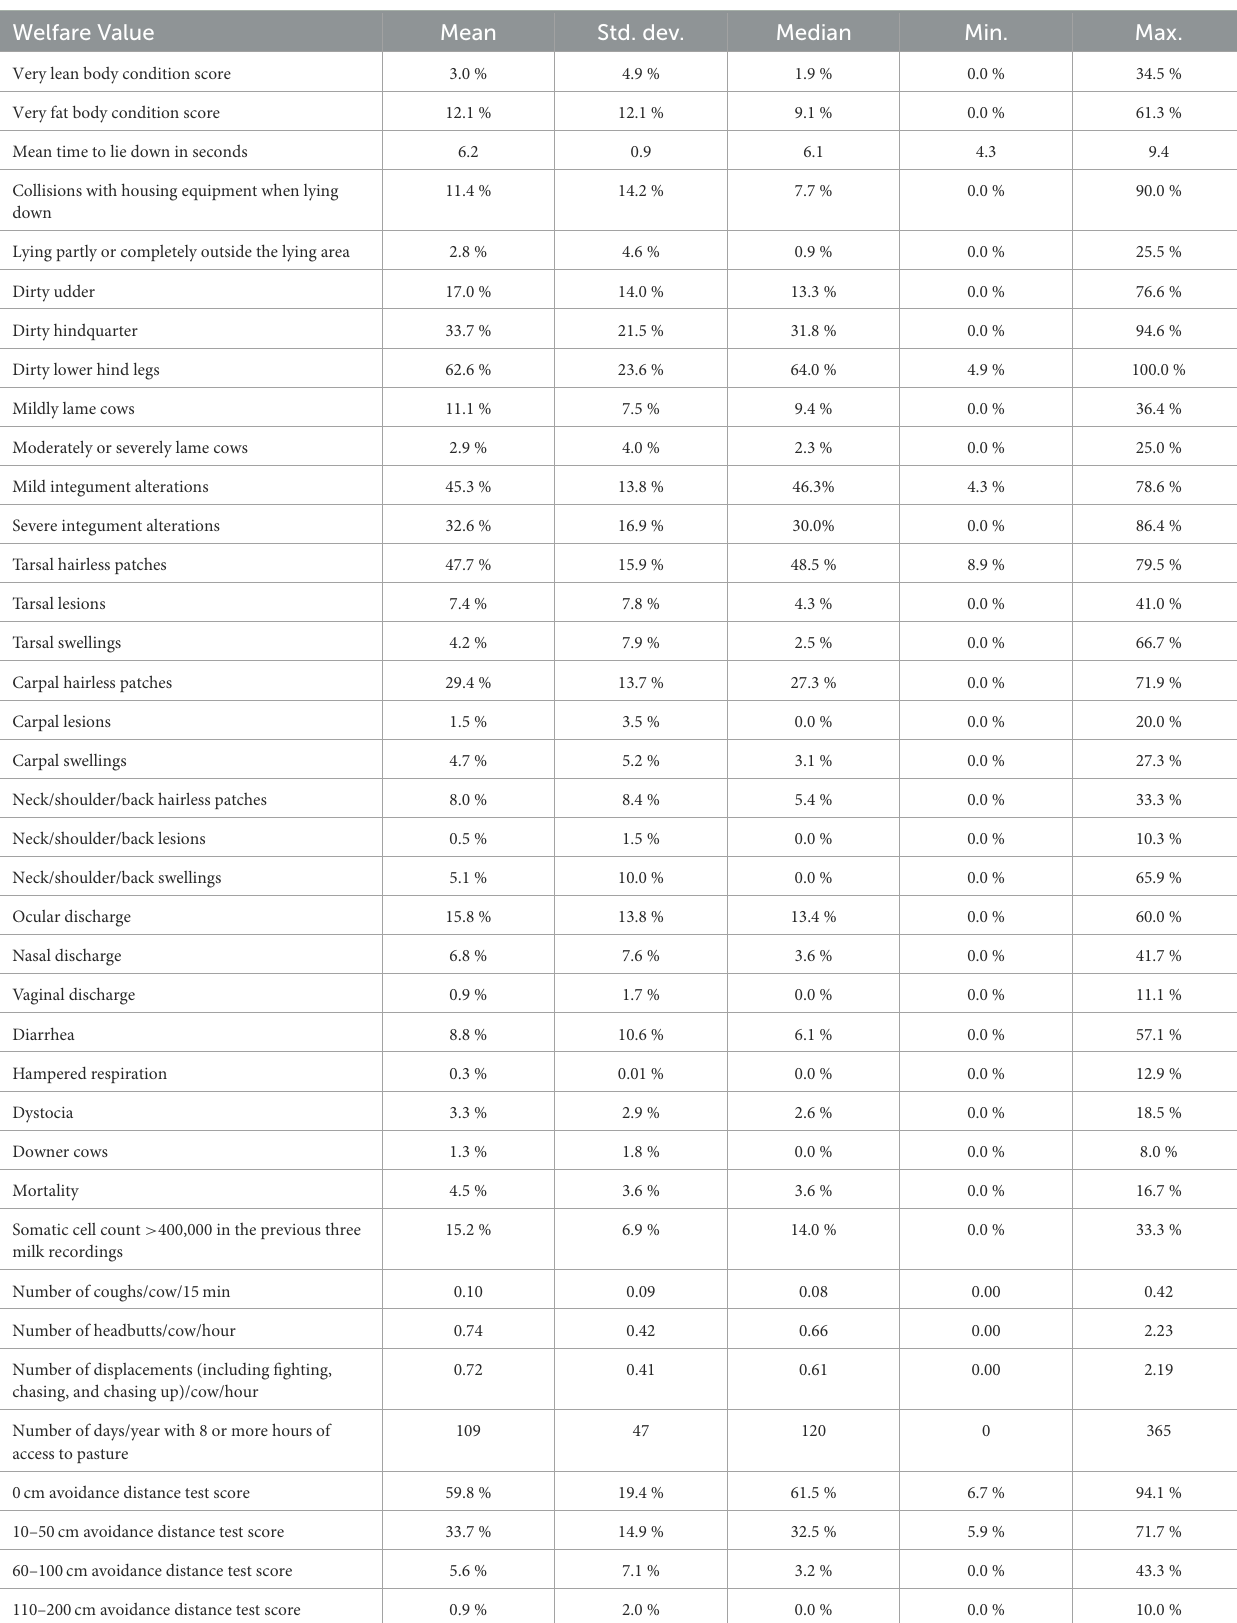
TABLE 5 Summary of observed prevalences and other herd-level registrations related to animal welfare in Norwegian loose-housed dairy herds ( n = 155) showing the mean, standard deviation of the mean, median, maximum, and minimum for each value. Welfare Value